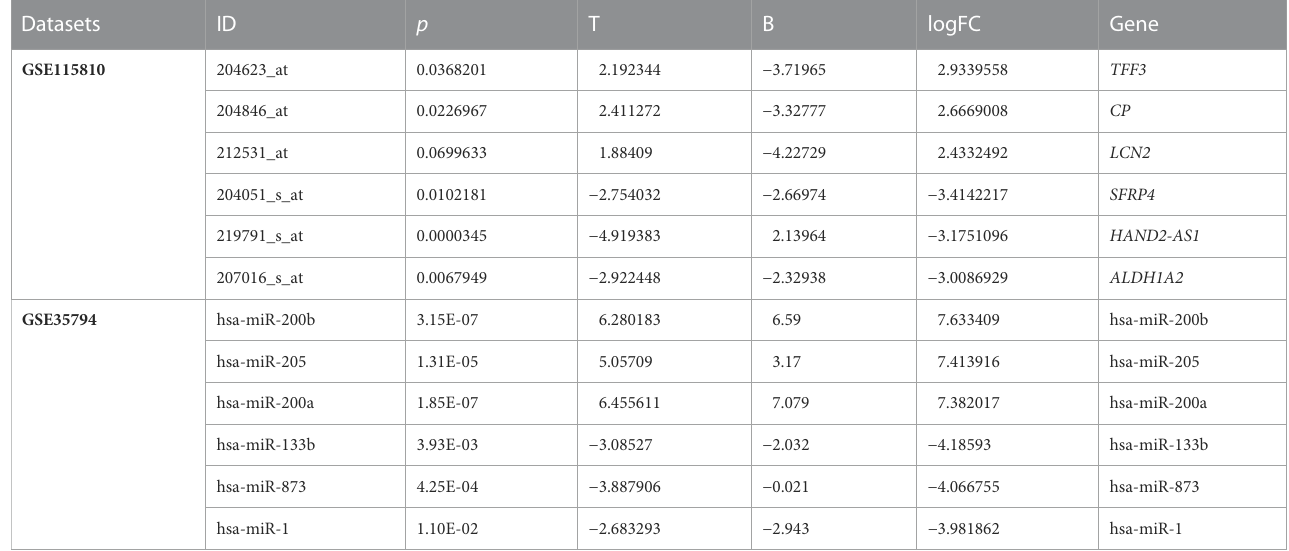
TABLE 1 The top six upregulated DEGs and DEmiRNAs in endometrial cancer tissues. Datasets